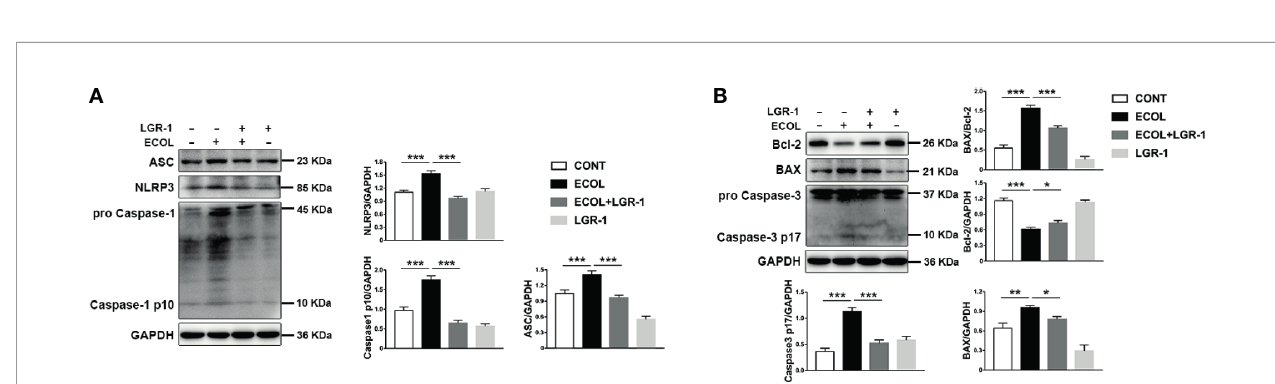
FIGURE 3 | LGR-1 alleviates Escherichia coli- induced NLRP3 in fl ammasome activation and apoptosis in MAC-T cells. (A, B) Western blot analysis of ASC, NLRP3, Caspase-1, BAX, Bcl-2, and Caspase-3. The lower right panel shows the protein quanti fi cation using ImageJ software (version 1.50) Con fl uent MAC-T cell were pretreated with LGR-1 (10 5 CFU/mL, MOI = 1) for 3 h, washed three times with PBS, and exposed to E coli (10 7 CFU/mL, MOI = 66). Cells were analyzed 8 h after E coli infection. Data presented are mean ± SEM; n = 3. * p < 0.05, ** p < 0.01, *** p <